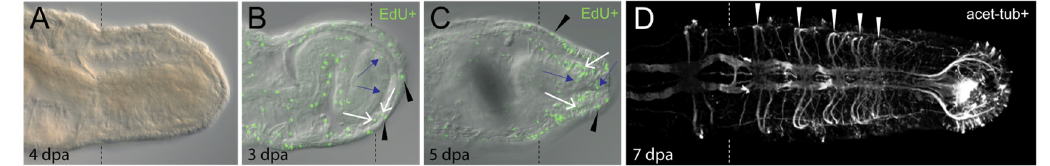
Figure 3. Capitella regenerates posterior segments. All panels show posterior end of regenerating juvenile animals in ventral view with anterior to the left. Dotted lines indicate position of amputation site. Animals were amputated between the 10th and 11th segment. ( A ) Posterior regeneration in Capitella . ( B , C ) Dividing cells are present in ectoderm (black arrowheads), mesoderm (white arrows) and endoderm (blue arrows). Green indicates cells in the S-phase of the cell cycle that have incorporated EdU (EdU+). ( D ) Confocal projection of regenerated ganglia and circumferential peripheral nerves of the central nervous system. White arrowheads indicate pairs of peripheral nerves emanating from newly formed ganglia in the regenerate. There is one ganglion/segment and, thus, five segments have formed in the regenerate. Nerves were labeled with an anti-acetylated tubulin antibody (acet-tub+). Images in B and C are adapted from [38]. Dpa, days post ampu- tation.